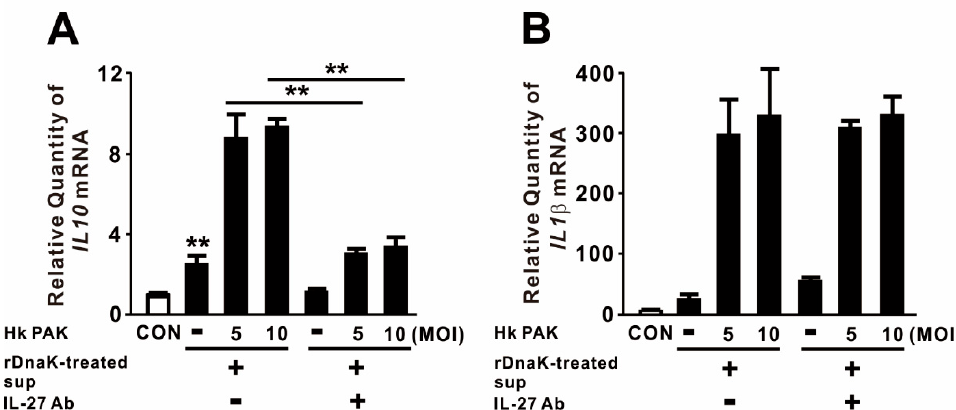
Figure 4. IL-27 produced in response to DnaK increases expression of IL10 . dTHP-1 cells were treated with 1 μ g/mL rDnaK for 16 h, and the supernatant was collected as conditioned medium (rDnaK-treated Sup). Conditioned media were incubated in the presence and absence of IL-27 antibody for 1 h at room temperature. These conditioned media were transferred to newly seeded dTHP-1 cells, and then the cells were treated with Hk PAK at an MOI of 5 or 10 for 4 h. After treatment, the mRNA levels of IL10 ( A ) and IL1 β ( B ) were measured by qRT-PCR. Data are expressed as means ± SD ( n = 3).